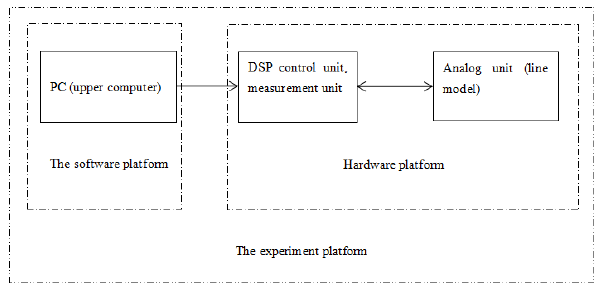
Figure 1: Protection experiment platform architecture